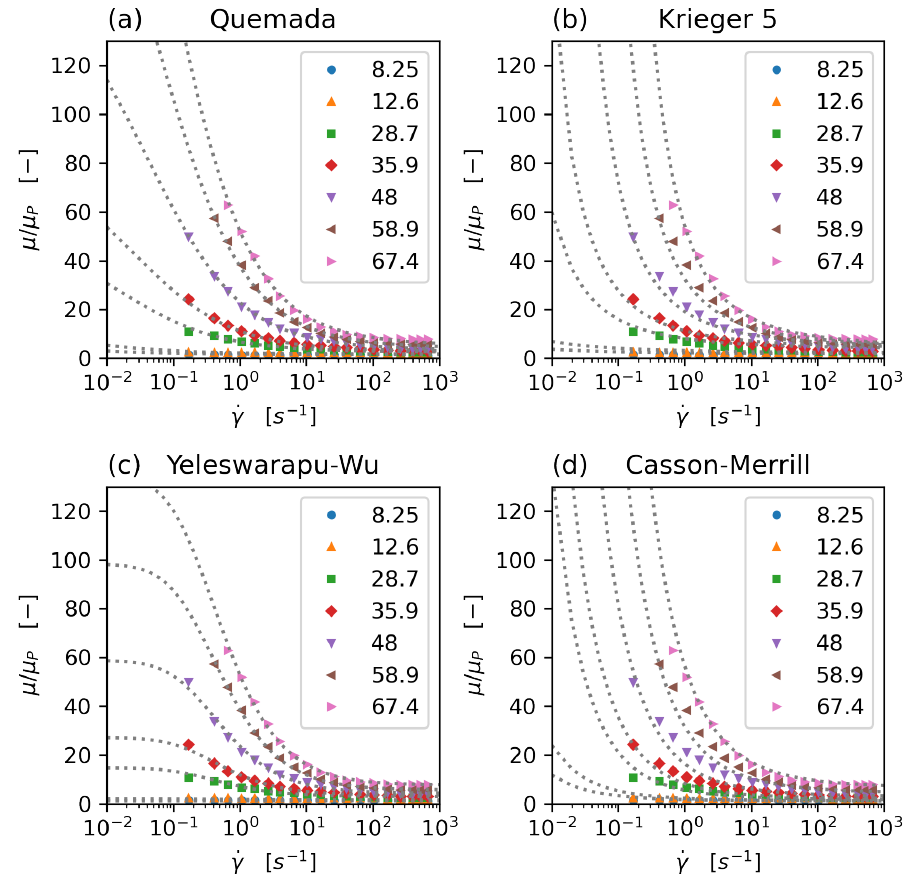
Figure 1. Comparison of non-Newtonian rheology models: Quemada ( a ), modified 5-parameter Krieger ( b ), Yeleswarapu-Wu ( c ), and Casson-Merril ( d ) model. All model parameters have been fitted to Brooks’ data. Dots: experimental data (Brooks), dotted lines: model equations, data series: haematocrit concentration. Table 1. Viscosity model parameters. Levenberg–Marquardt least squares fit (SciPy, MINPACK),